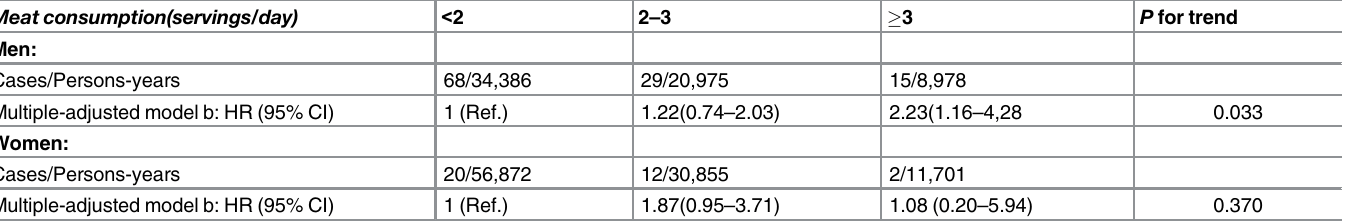
Table 5. HR and 95% CI for incident type 2 diabetes according to categories of daily meat consumption according to sex. The SUN Project 1999 –